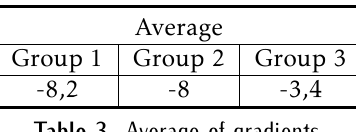
Table 3. Average of gradients. For children group, the percentage of